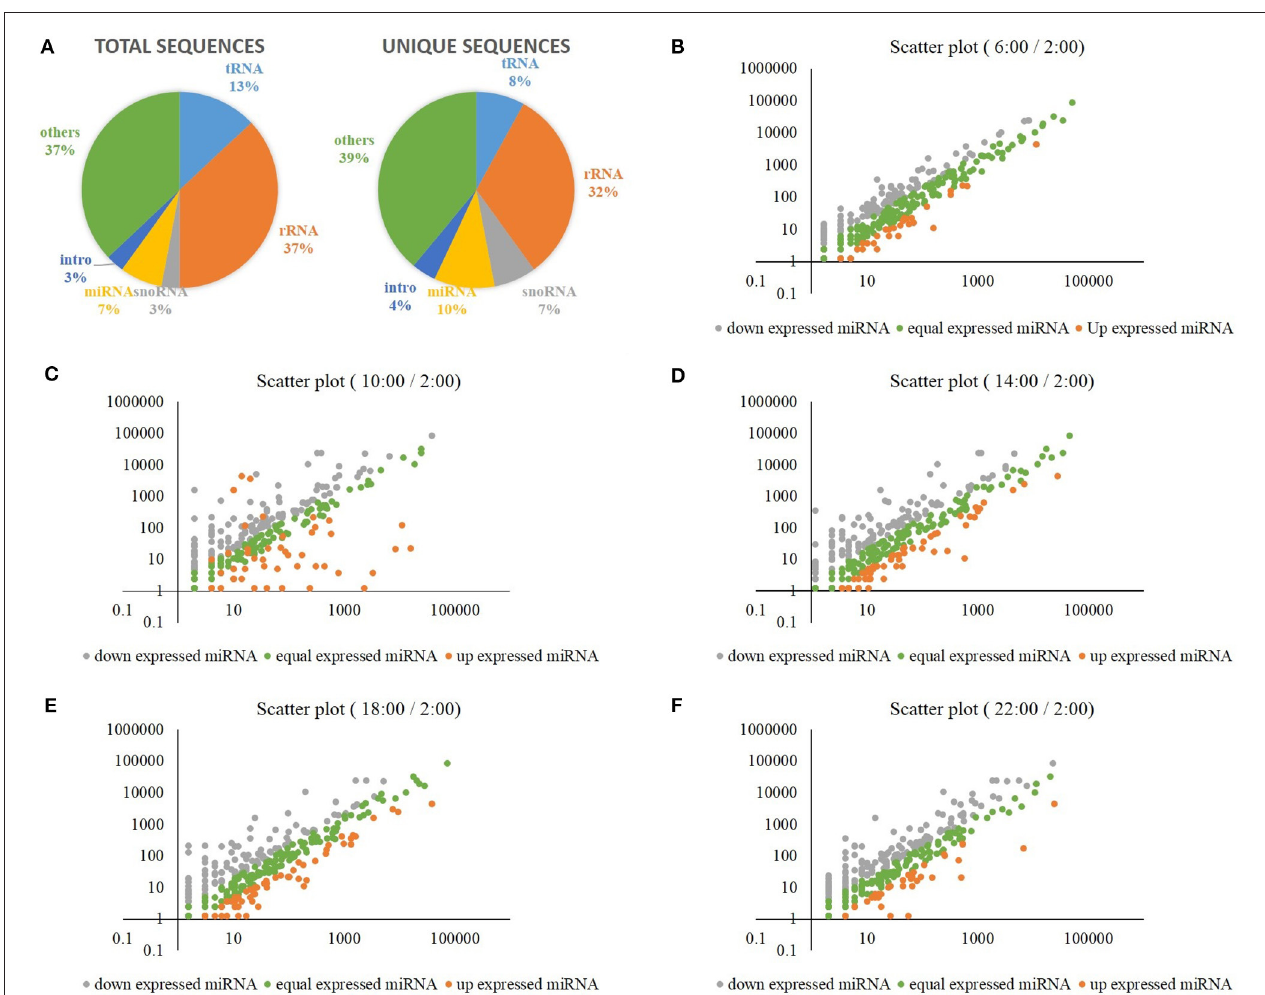
FIGURE 5 | (A) The annotations of total and unique sRNA sequences, which were blasted with non-coding RNAs in the database of Rfam (11.0). (B) Differentially expressed mature miRNAs at the time of 6:00 when compared to the time of 2:00. (C) Differentially expressed mature miRNAs at the time of 10:00 when compared to the time of 2:00. (D) Differentially expressed mature miRNAs at the time of 14:00 when compared to the time of 2:00. (E) Differentially expressed mature miRNAs at the time of 18:00 when compared to the time of 2:00. (F) Differentially expressed mature miRNAs at the time of 22:00 when compared to the time of